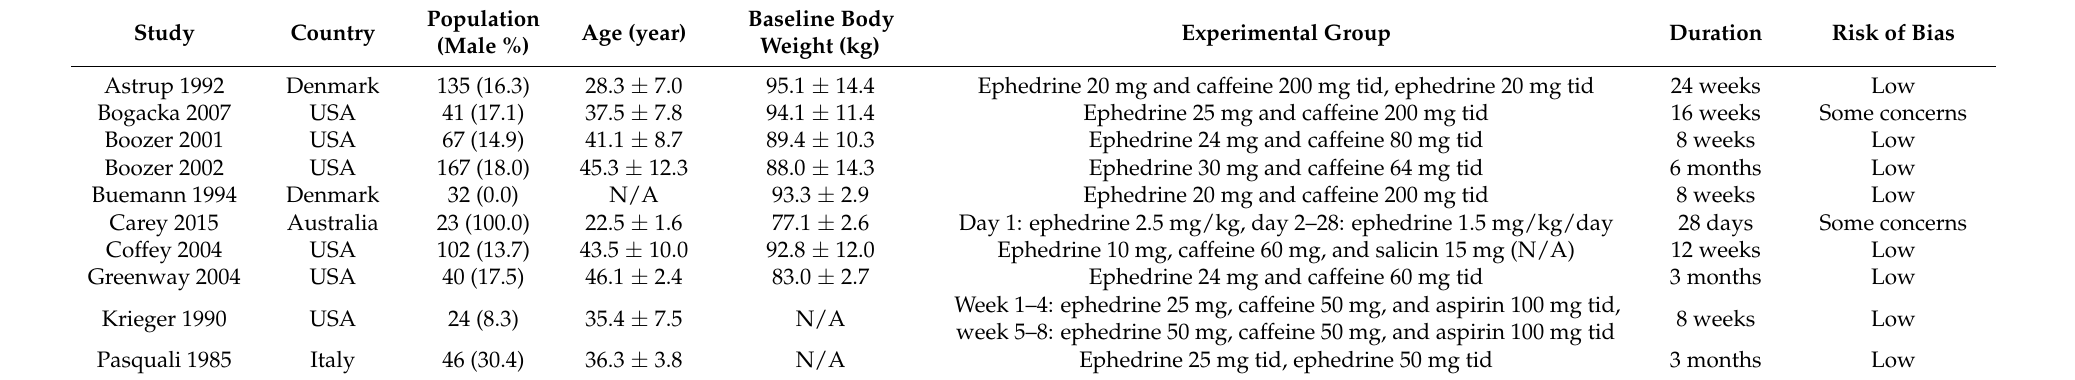
Table 1. Summary of included